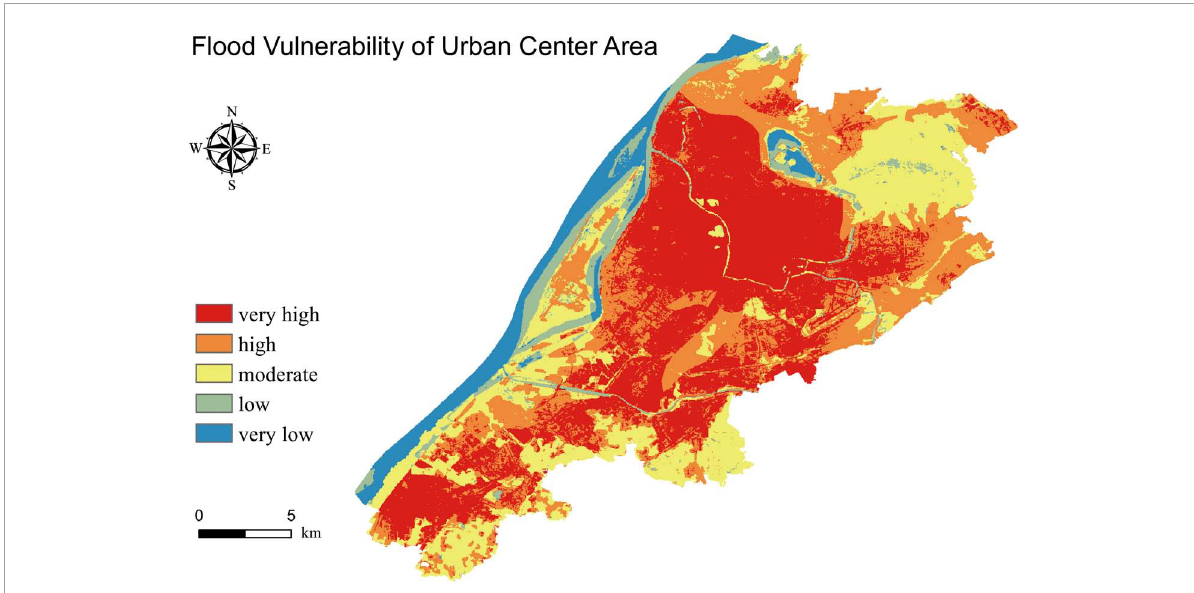
FIGURE5 The flood vulnerability levels of urban center